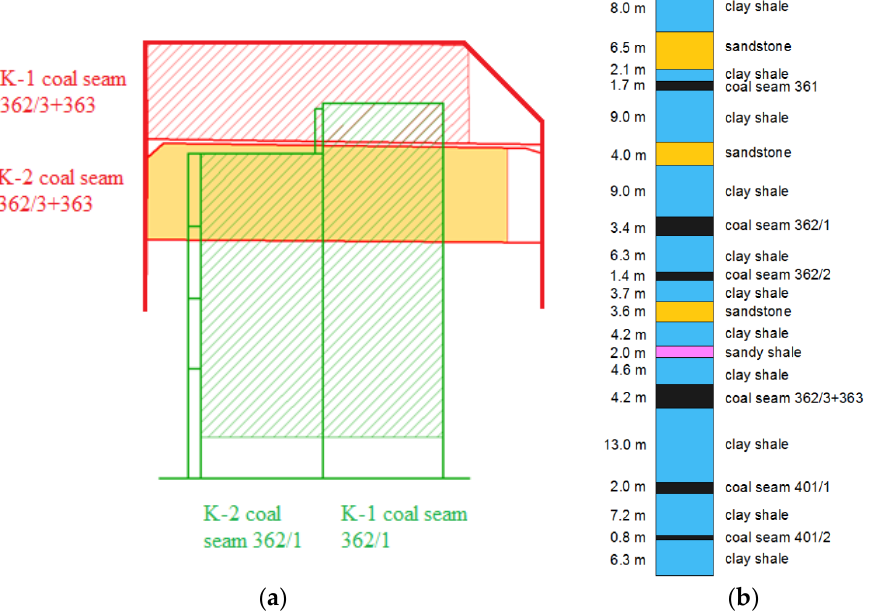
Figure 6. Outline of the K-2 longwall in coal seam 362/3 + 363 ( a ), and fragment of the lithological profile around the K-2 longwall ( b ).